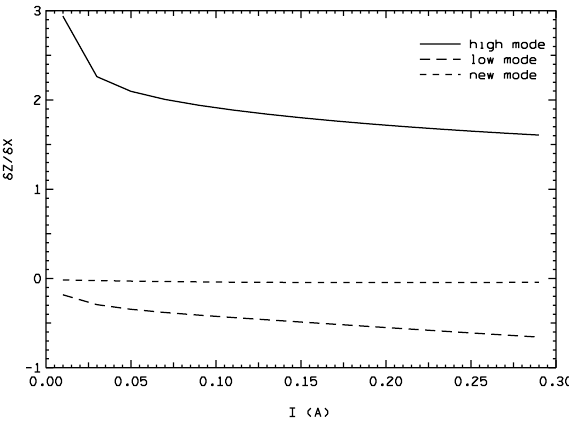
FIG. 5. The ratio of relative amplitude of longitudinal oscil- lation to that of transverse oscillation, d R z (cid:1) d R x , for the high mode and the low mode as a function of current.